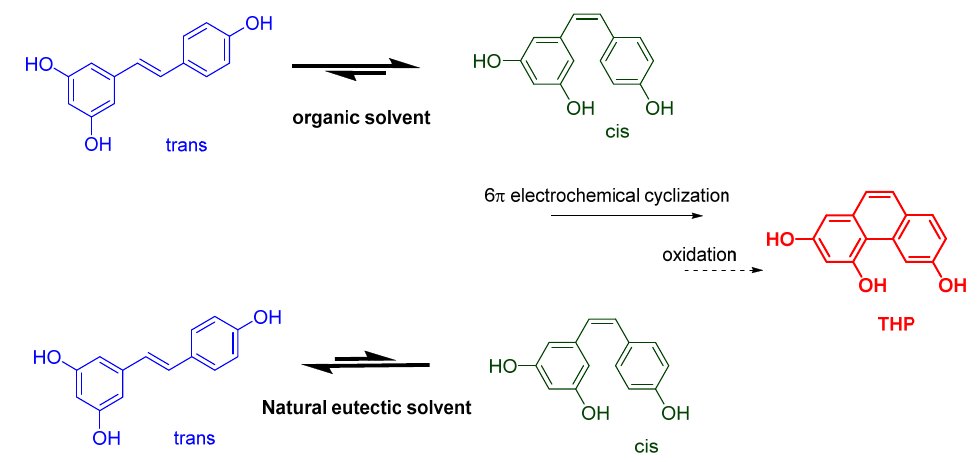
Figure 9. Photochemical equilibrium during trans -resveratrol UV-light irradiation. The trans / cis equilibrium in the photostationary state is generally shifted to the right for resveratrol in organic solvent solution (upper part of the graph). On the contrary, in glycerol-based NaDES solutions, the equilibrium is shifted to the left stabilizing the trans - isomeric form (lower part of the graph).